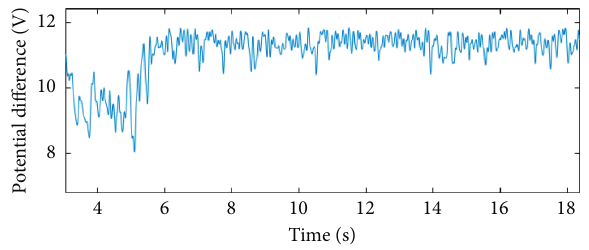
Figure 9: Experimental waveform of the difference Vc 1- Vc 2 re- sponse to a change in the duty cycle.